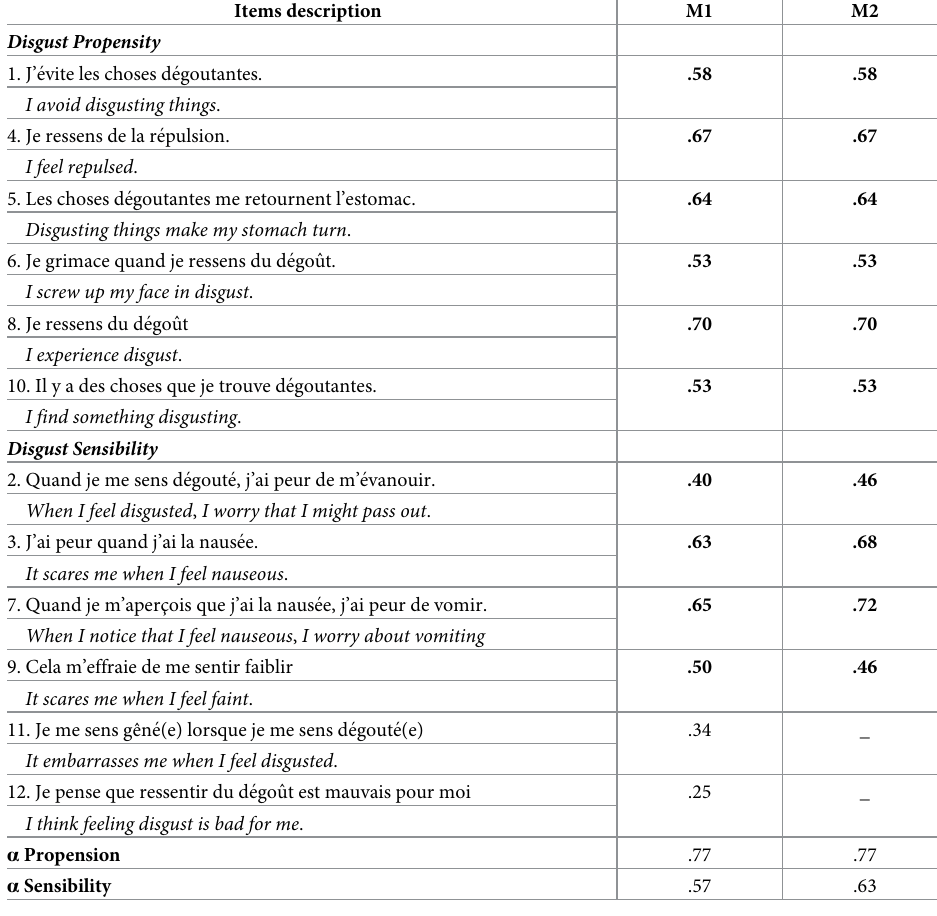
Table 1. Confirmatory factor analysis and item statistics of the disgust propensity and sensitivity scale revised-12 (DPSS-12) ( N = 282). Items